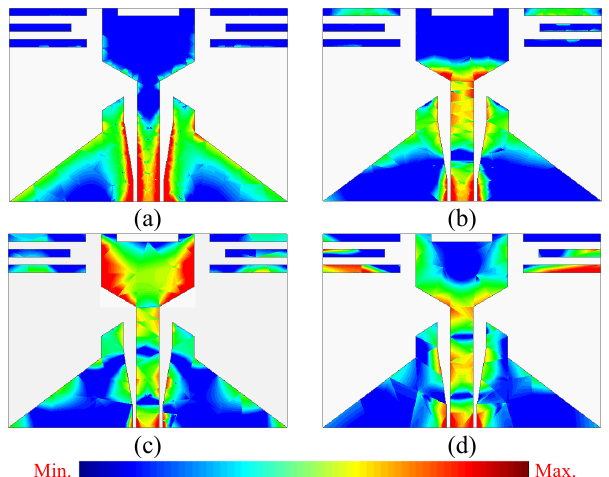
FIGURE 8. Simulated current distributions of the proposed CPW-fed UWB antenna at: (a) 4 GHz, (b) 8 GHz, (c) 12 GHz, and (d) 16 GHz.